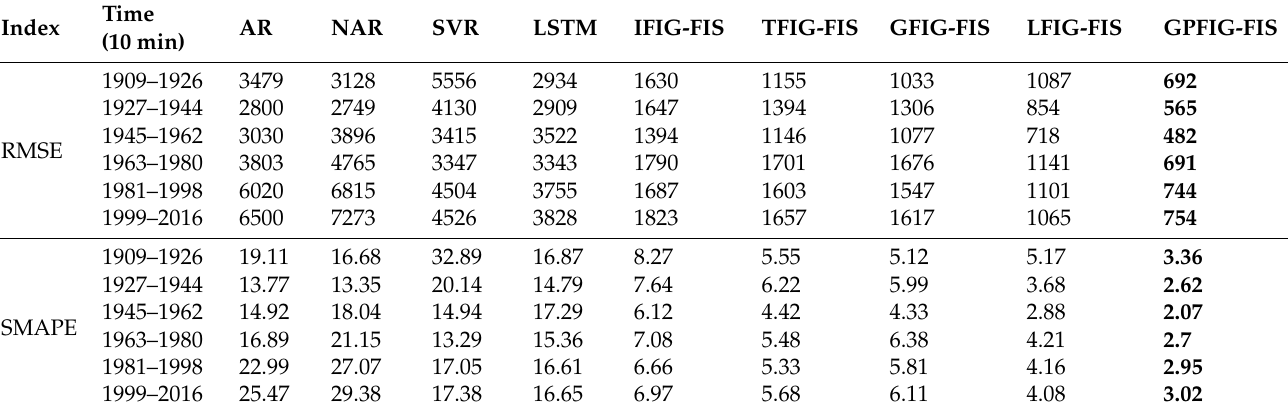
Table 2. Comparison of the prediction indexes of electricity consumption in Tetuan.